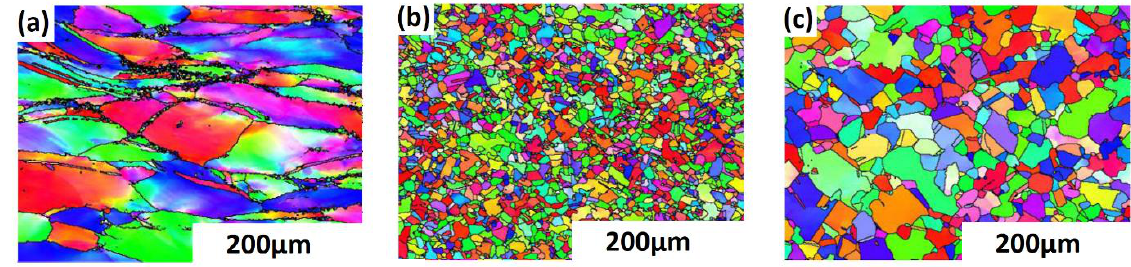
Figure 7. Inverse pole figure maps of microstructures of new nickel-based superalloy at 0.01 s − 1 for ( a ) 950 ◦ C, ( b ) 1050 ◦ C, and ( c ) 1150 ◦ C